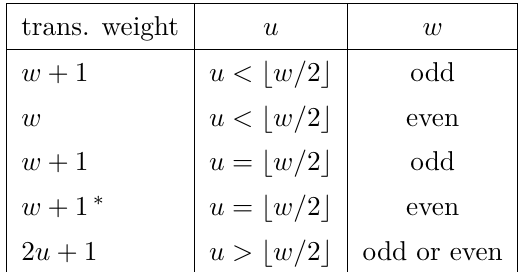
Table 1 . The transcendental weights of the integral of E ∗ w = s + t + u . The asterisk in the case of w = 2 u denotes the presence of a term proportional to ln(2 π )